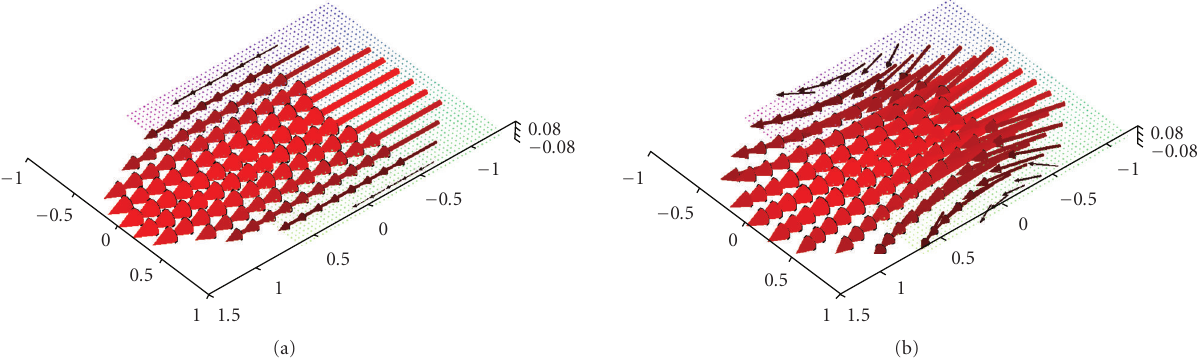
Figure 4: (a) Original vector field f ( x ) = (1 − x 2 2 − x 2 3 ,0,0) (cid:9) . (b) Reconstruction with the described algorithm for γ = 0 . 007 using exact, simulated data D 1 f .